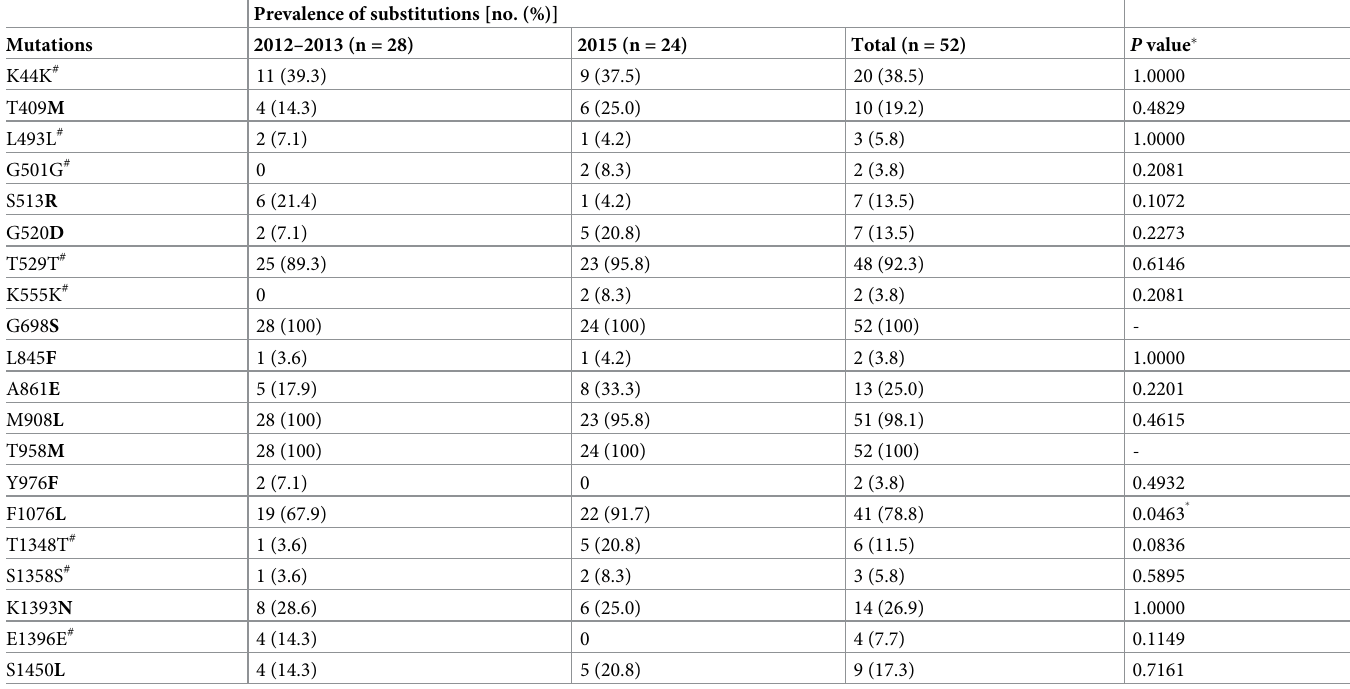
Table 2. The prevalence of Pvmdr1 substitutions in 52 parasite isolates. Prevalence of substitutions [no.